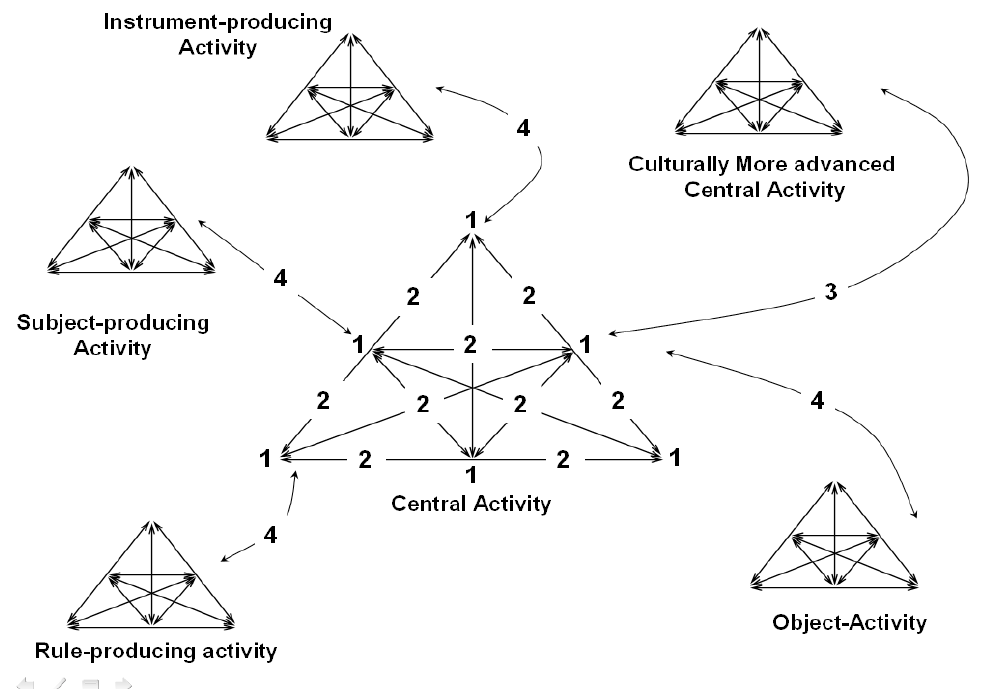
Figure 3 . Interactions of surrounding activities and potential contradictions within and between them (Engeström,